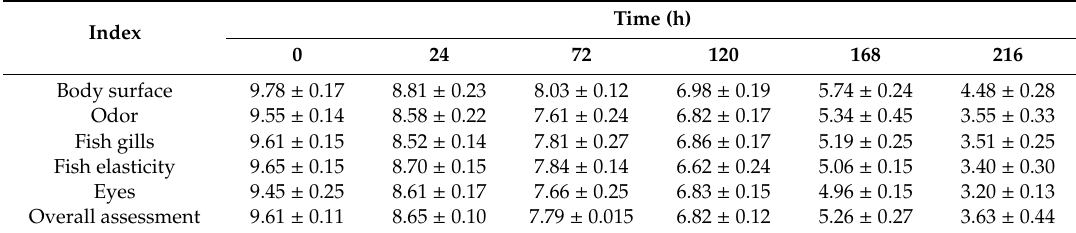
Table 2. Sensory Score of Spanish Mackerel at the 0 ◦ C Cold Chain Storage